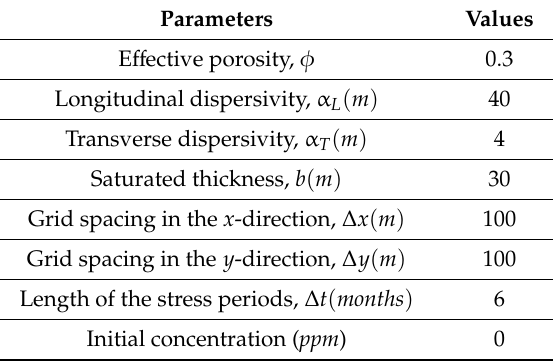
Figure 3. Two-dimensional aquifer model. Table 2. Case 1: hydraulic and geometry characteristics.